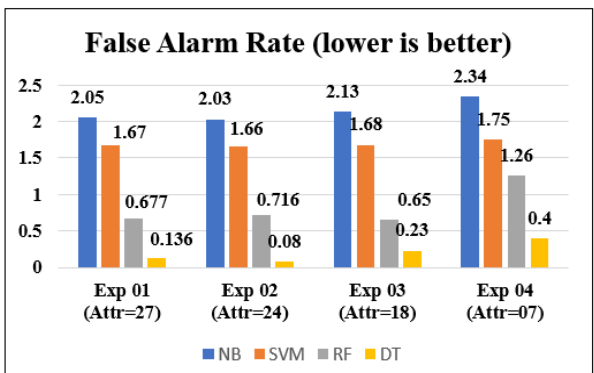
Figure 6. False Alarm Rate.